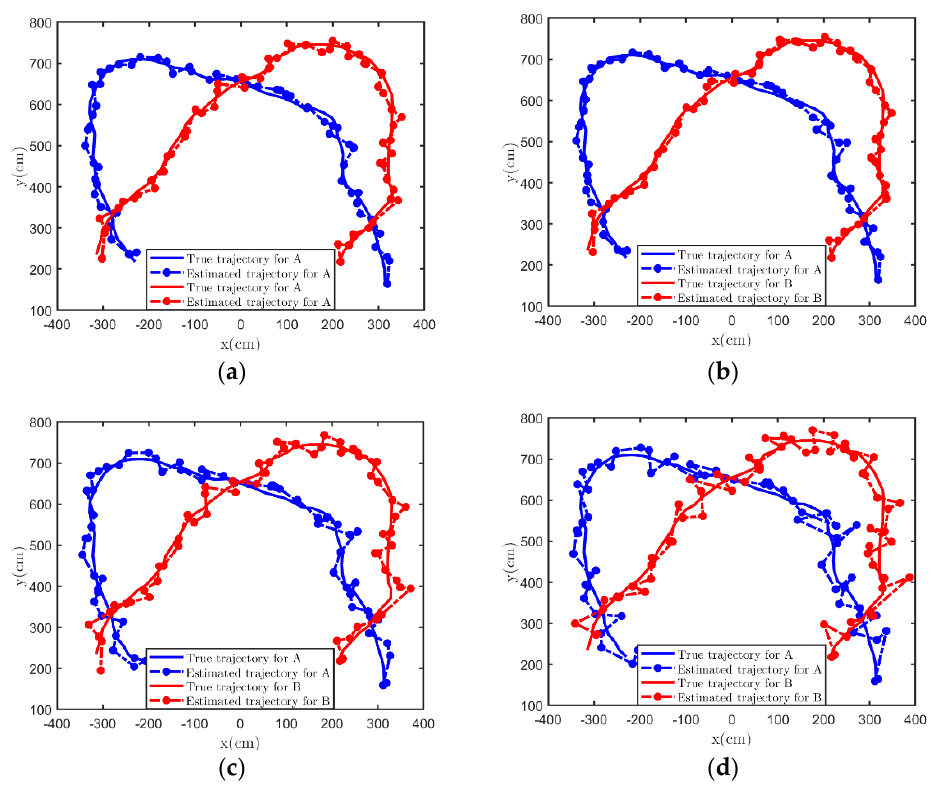
Figure 9. The fitting degree between the estimated trajectory and the true trajectory after processing by various Kalman filtering methods in an outdoor scene. ( a ) OBKF. ( b ) KFPNS. ( c ) IBRKF. ( d ) CKF.